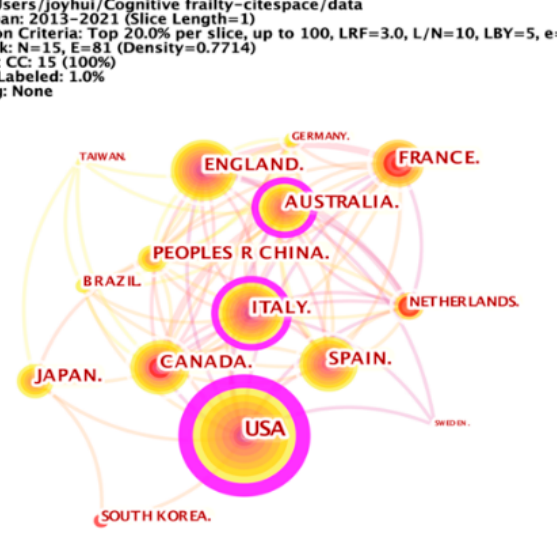
Figure 2. Collaboration network of countries/regions. The United States, Italy, and Australia have made great contributions to the research field of cognitive frailty, and have closely cooperated with other countries/regions.